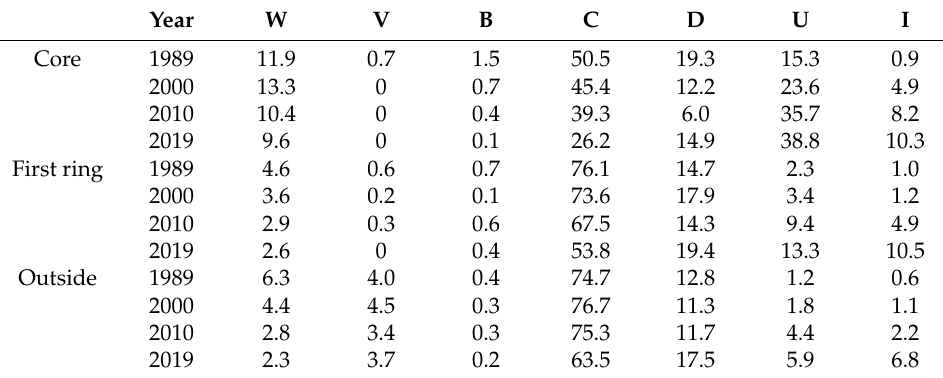
Figure 5. LULC classes (as percentages) in the three rings between 1989 and 2019 (WW: water; B: bare soil; V: vegetated areas; C: cultivated areas; D: discontinuous built-up areas; U: urban areas; I: industries and commercial complexes). Table 6. LULC (as percentages) by rings between 1989 and 2019.